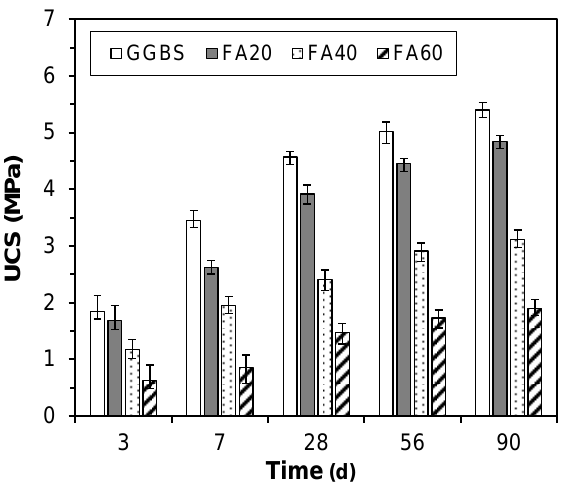
Figure 8. FA ’s effect on AAS- CPB’s strength development . Figure 8. FA’s effect on AAS-CPB’s strength